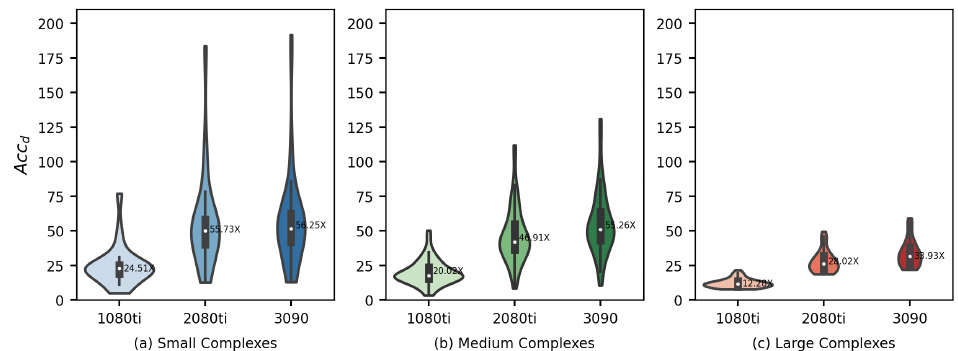
Figure 8. Acceleration ratio on Acc d of our Vina-GPU against AutoDock Vina on three different GPUs and various scales of complexity according to their N atom sizes (small—5–23 atoms, medium— 24–36 atoms, large—37–108 atoms). 1080ti—NVIDIA Geforce GTX 1080ti; 2080ti—Nvidia Geforce RTX 2080Ti; 3090—Nvidia Geforce RTX